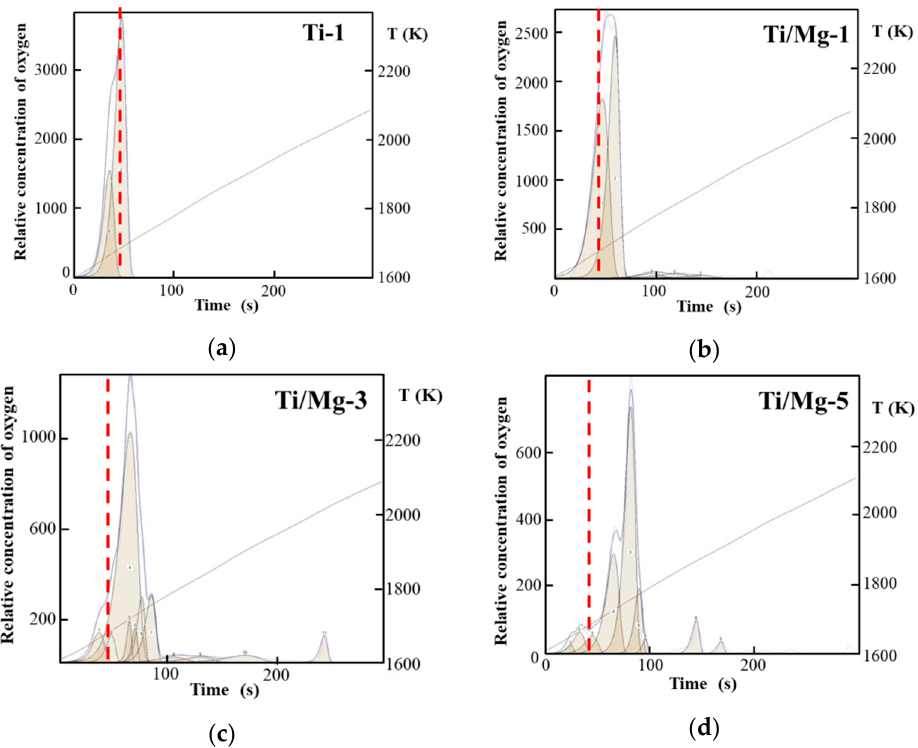
Figure 7. Typical time charts obtained by FGA measurements of oxide inclusions in metal specimens from the Ti and Ti/Mg experiments: ( a ) Ti-1, ( b ) Ti/Mg-1, ( c ) Ti/Mg-3 and ( d ) Ti/Mg-5.